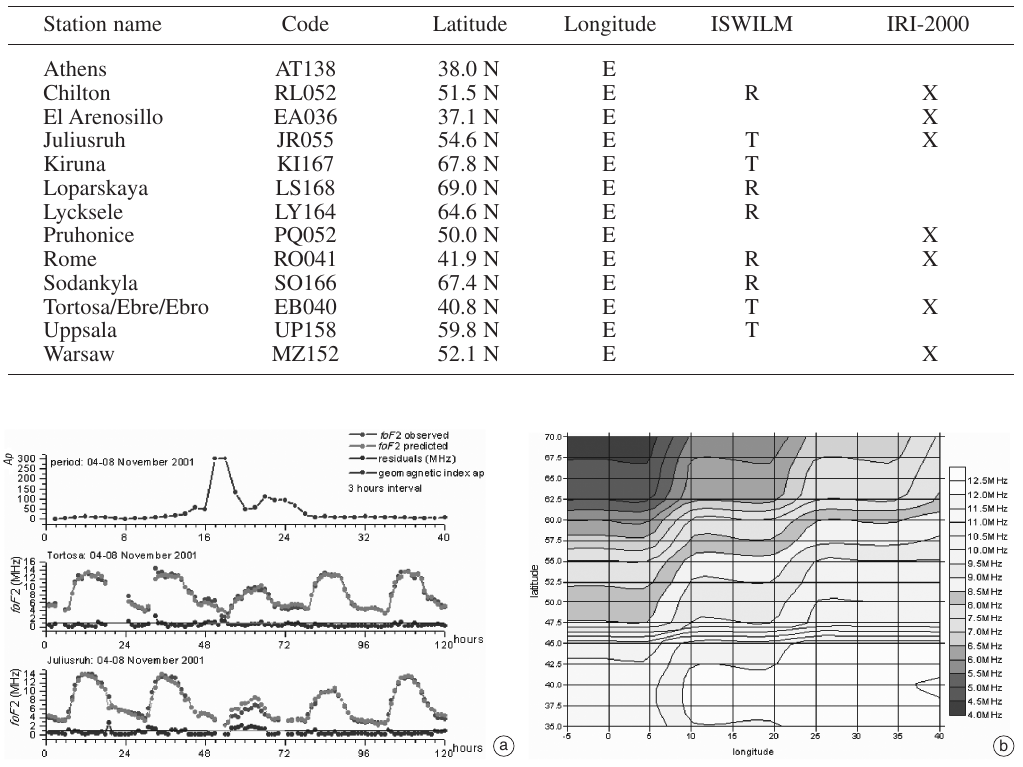
Fig. 3.8a,b. Outputs from the ISWILM model: a) the predictions for Tortosa and Juliusruh for 4-8 November 2001; b) instantaneous mapping of foF 2 for 7 November 2001.